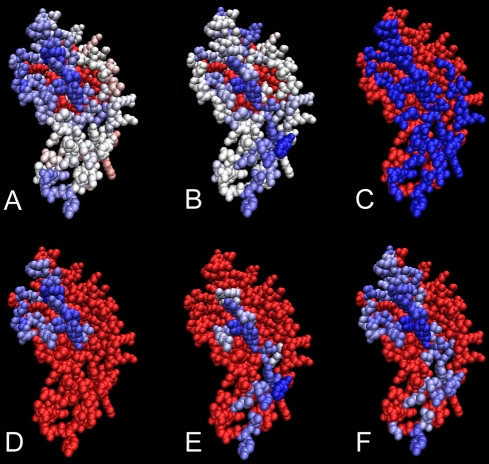
JET prediction of an interaction site based on the combination of
conservation and physical-chemical signals.Allophycocyanin structure (PDB file 1all:B). Top: residues are colored
from blue (strong signal) to red (low signal) passing through white by
conservation (A) and by physical-chemical properties (B), with
inaccessible residues in red. The experimental interaction site is blue
in (C). Bottom: cluster seeds computed based on conservation (D) and
based on physical-chemical properties (E) are colored from blue to white
accordingly to  and  values respectively. Prediction (F) is computed by
extending both seeds in (D) and (E); colors map mixed trace values.